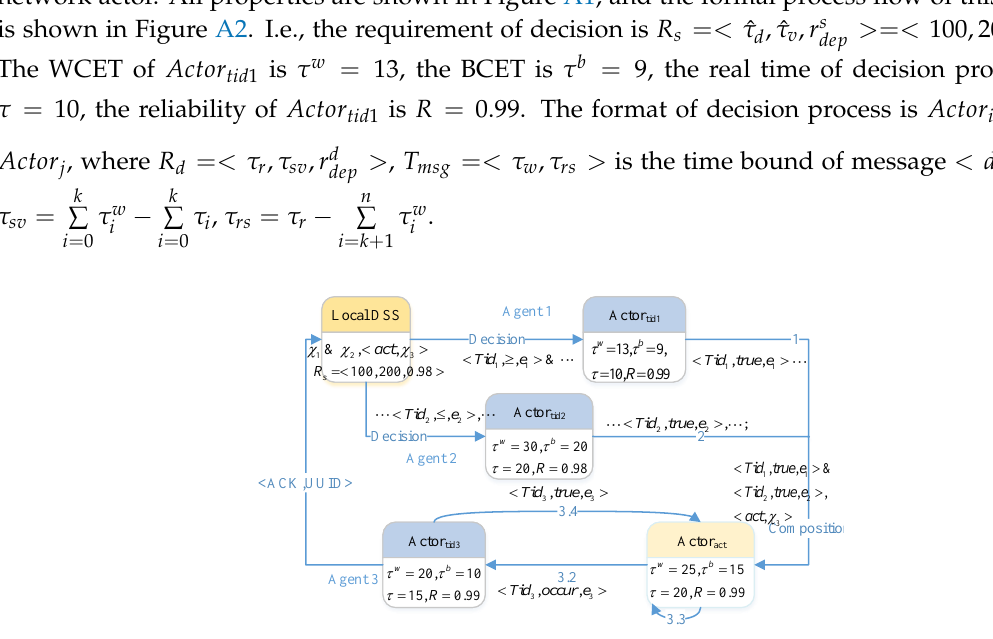
Figure A1. Simplified decentralized decision process.